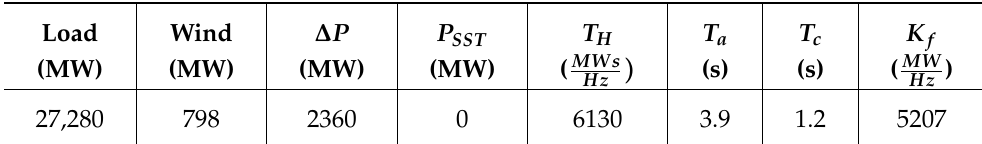
Table 1. Conditions and parameters for performing the system identification. Reproduced from [15], IEEE: